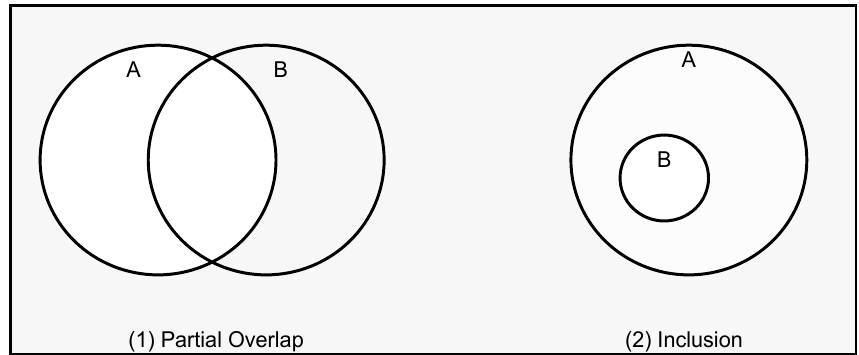
Figure 3. Euler diagram classification.